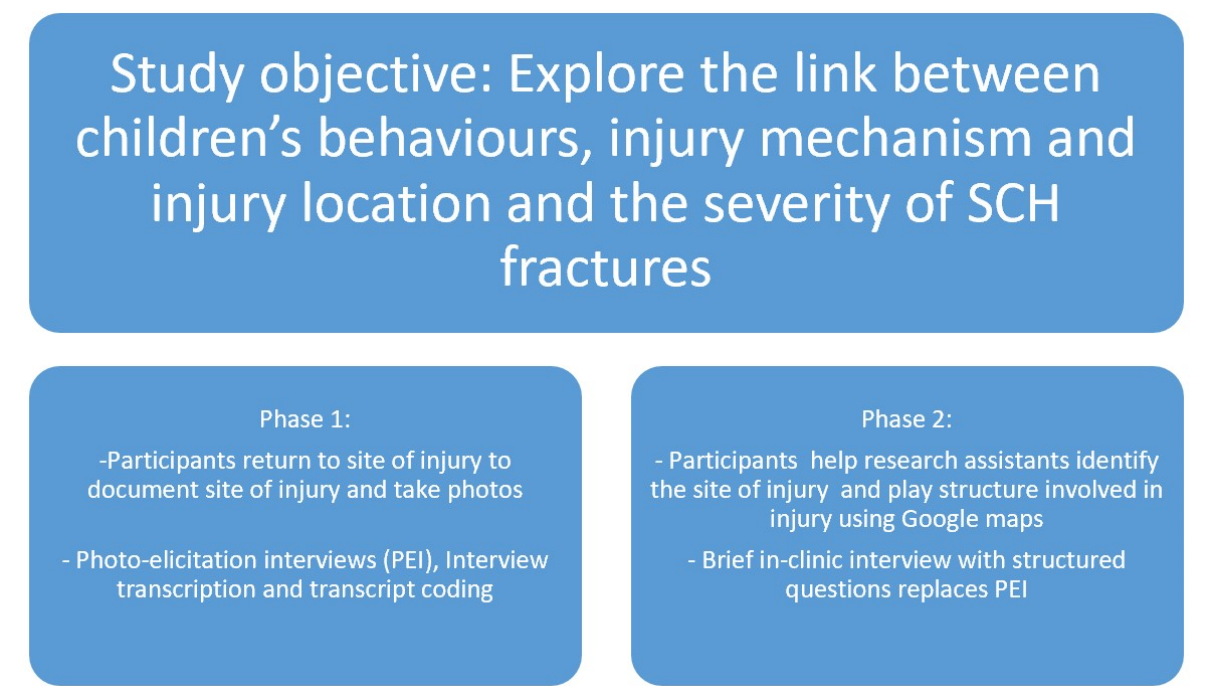
Figure 1. Study objective with the key components from each phase of the study.